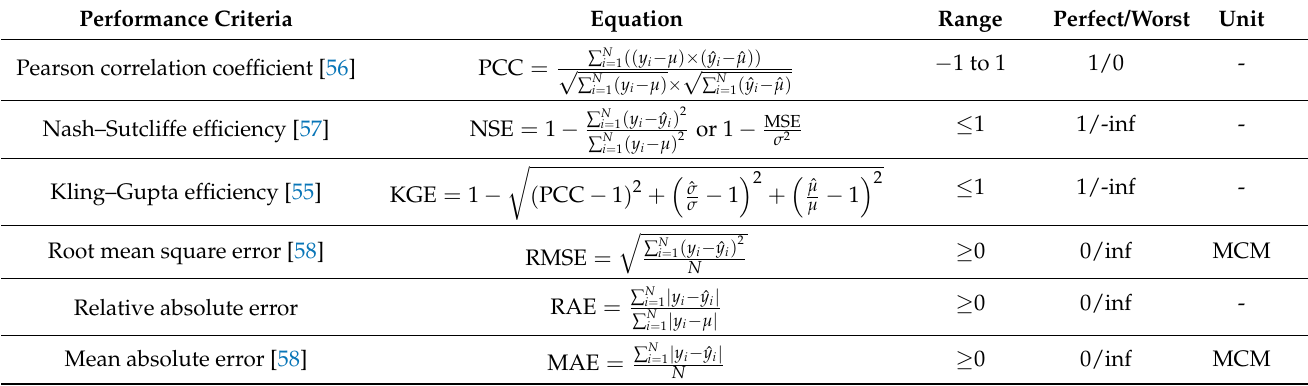
Table 3. The performance criteria to compare observed runoff values y i to the estimated runoff values ˆ y i ( N is sample